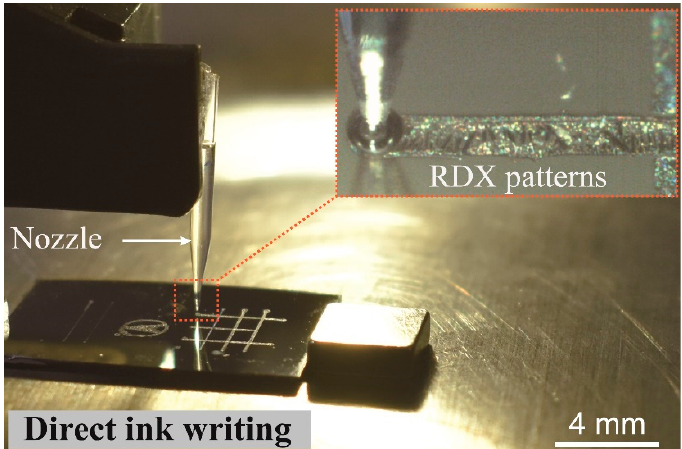
Figure 1. Picture of the direct ink writing system, with a focus on the dispensing unit (nozzle). The inset shows 1,3,5-trinitro-1,3,5-triazinane (RDX) ink being dispensed.